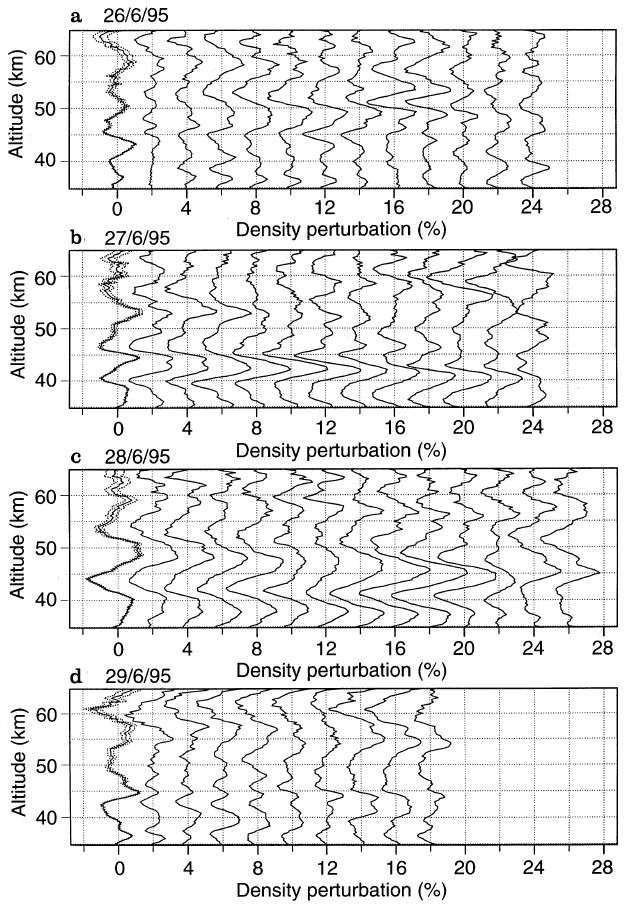
Fig. 3a–d. Profiles of percentage density fluctuations derived from 20- min observations on the nights of a 26, b 27, c 28 and d 29 June 1995, successive profile values being o(cid:128)set by 2% density perturbation. The estimated uncertainities for the first profile for each night are